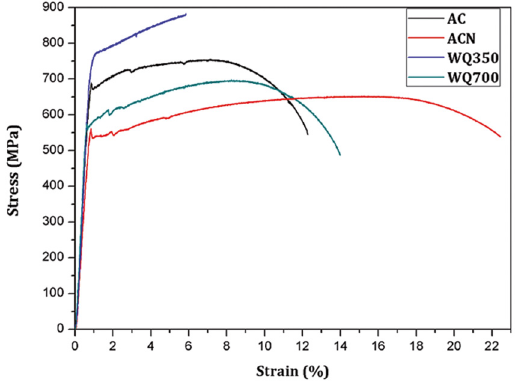
Figure 4: Engineering stress-strain curves of investigated